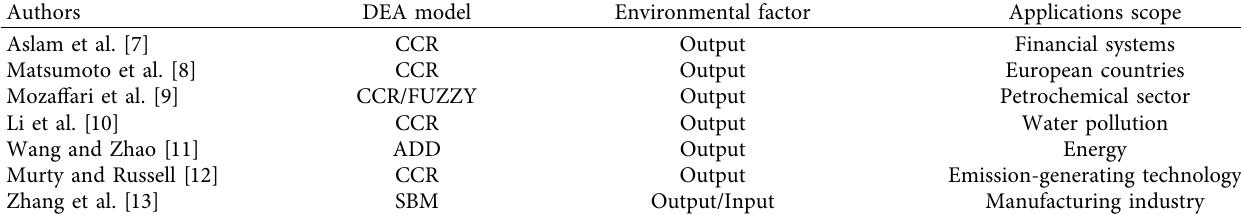
Table 1: Some advances of environmental factor applications in